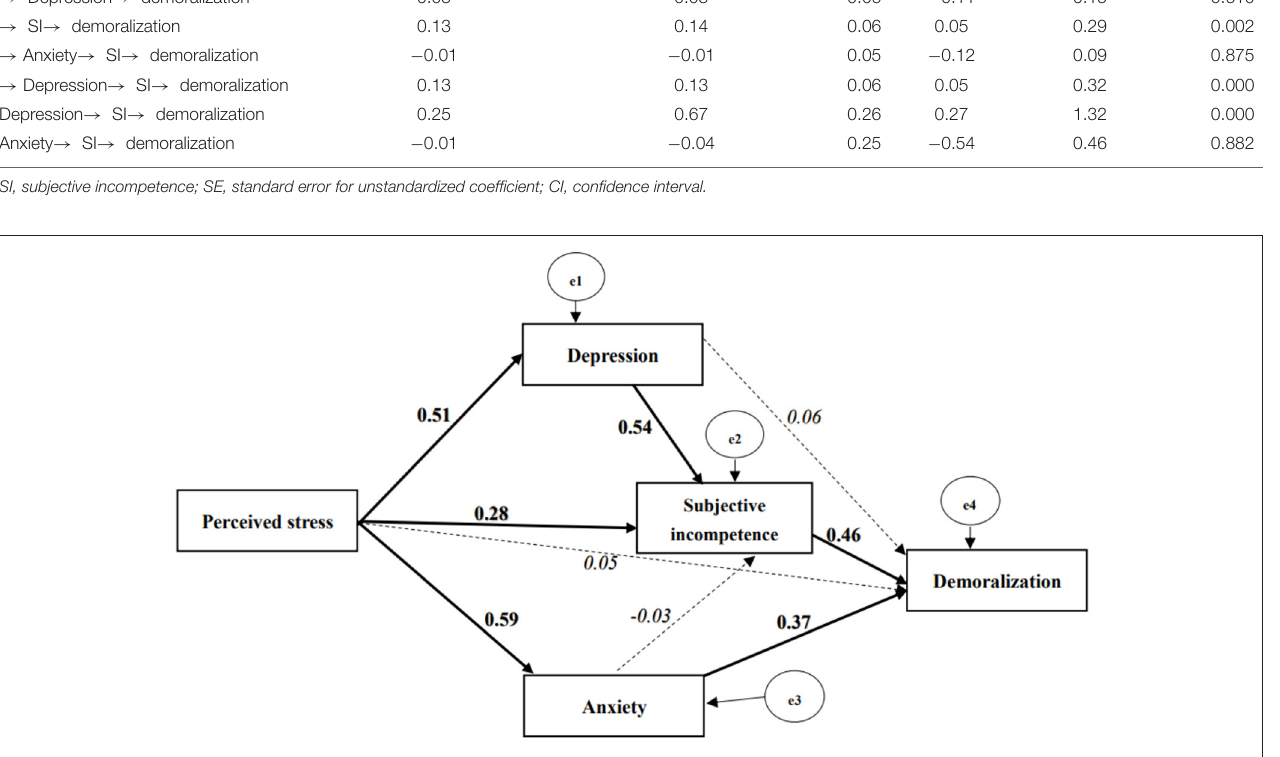
FIGURE 2 | Path model of the proposed effects of perceived stress, subjective incompetence, depression, and anxiety on demoralization with standardized coefficients. Continuous line, bold font indicates significant parameter ( p value ≤ 0.05); dash line, Italic font indicates non-significant parameter; the e1 and e3 were assumed to be correlated, and the coefficient was fixed to the value of partial co-variance between depression and anxiety controlled for perceived stress. Model fit, Chi-square < 0.001, P value = 1.000; TLI = 1.04; CFI = 1.00; RMSEA <